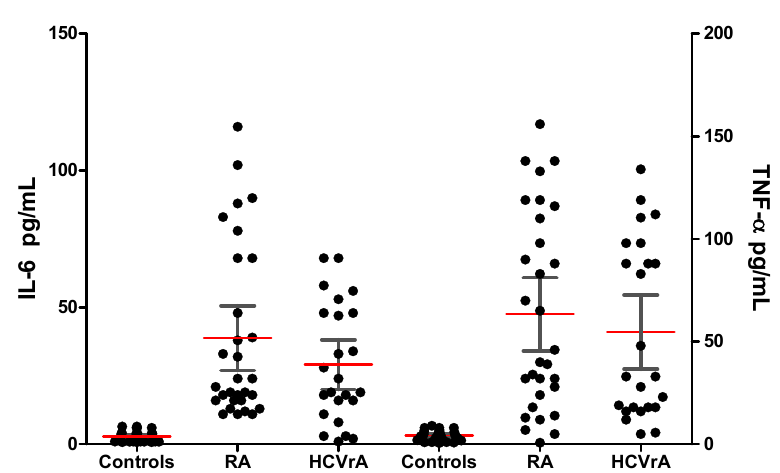
Figure 1. Interleukin 6 (IL-6) and tumor necrosis factor- α (TNF- α ) concentrations in serum of patients in both subgroups and control group (Black circles represent IL-6 and TNF- α concentration of individual serum samples; red lines represent mean values accompanied by 95% confidence interval; 95% confidence interval is represented by black horizontal bars).